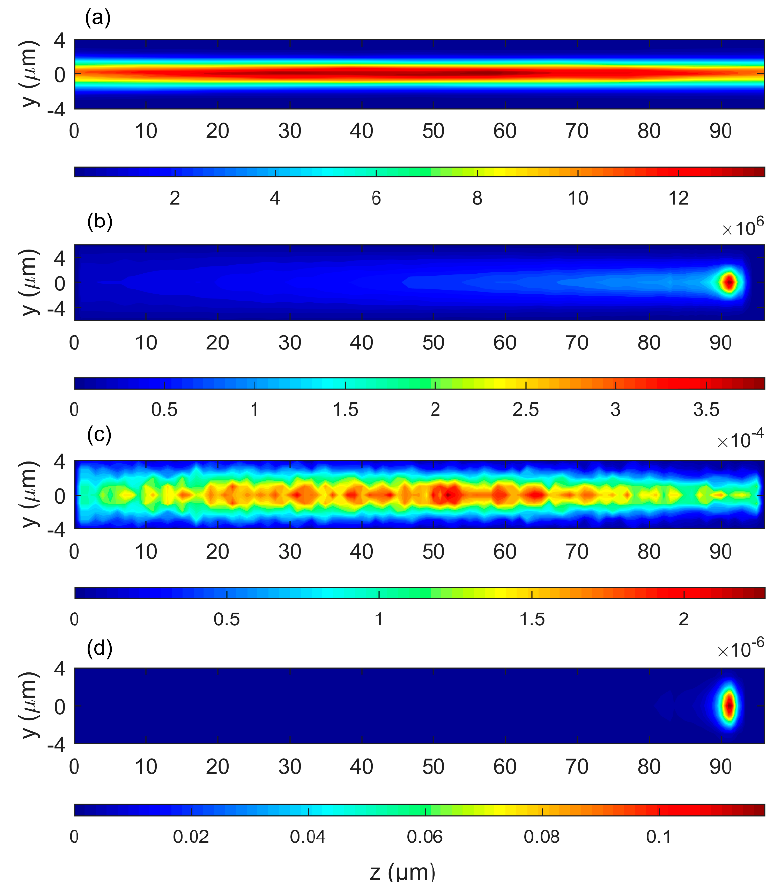
Figure 4. 2D simulation contour profiles in 96 µ m × 96 µ m DF channel: ( a ) The illumination irradiance profile through the channel; ( b ) The feedback light power re-entering-cavity coupling e ffi ciency r ext profile of 4.89 µ m PS particle in the channel without any coating; ( c ) r ext profile of 552 nm PS particle in the channel without gold coating; ( d ) r ext profile of 4.89 µ m PS in the channel with gold coating on the rear